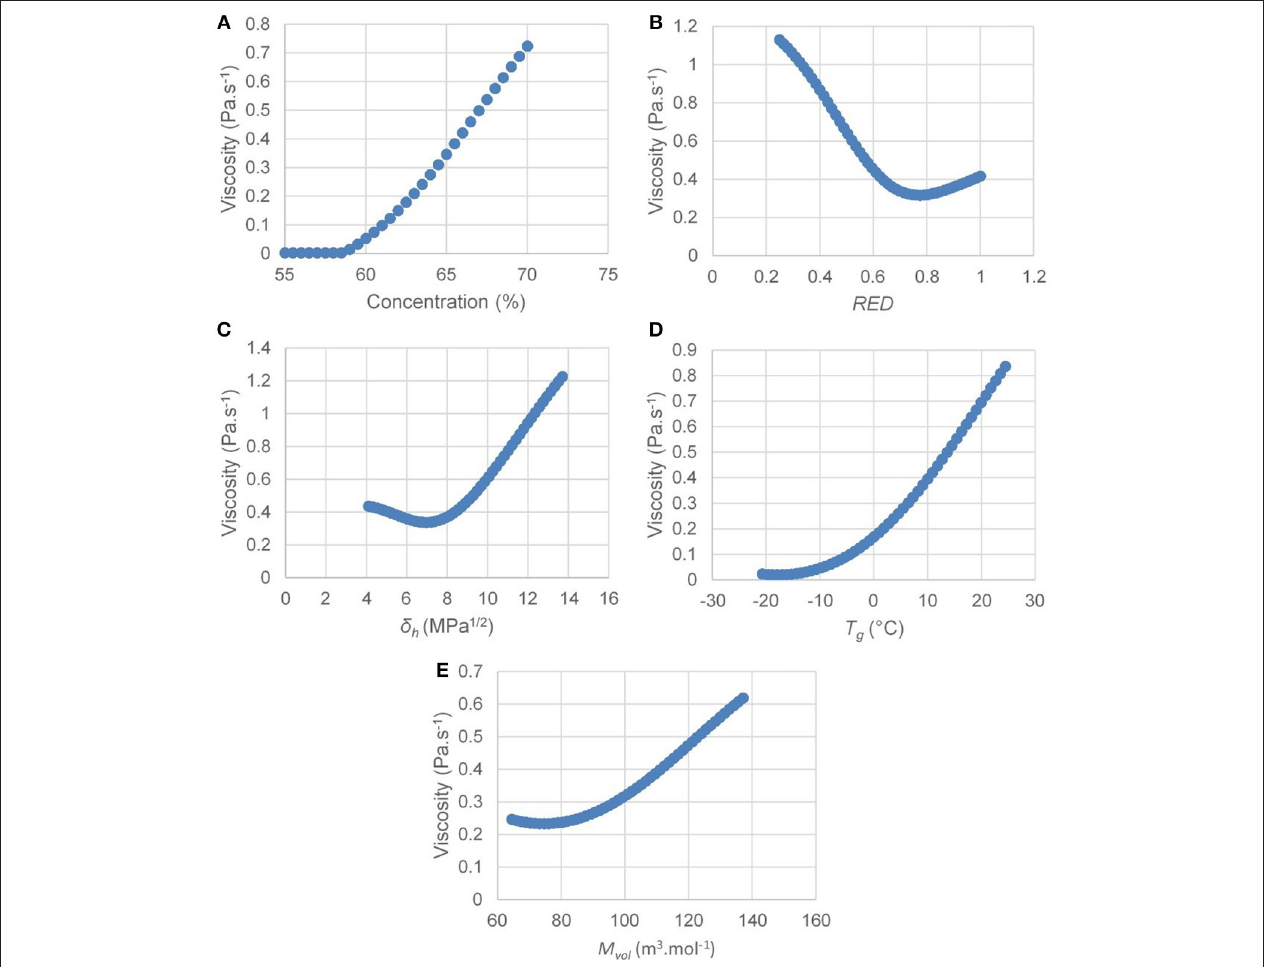
FIGURE 7 | Influence of each descriptor used in the neural network on the unsaturated polyester viscosity in solution [ (A) influence of concentration; (B ) influence of RED ; (C) influence of δ h ; (D) influence of T g ; (E) influence of M vol